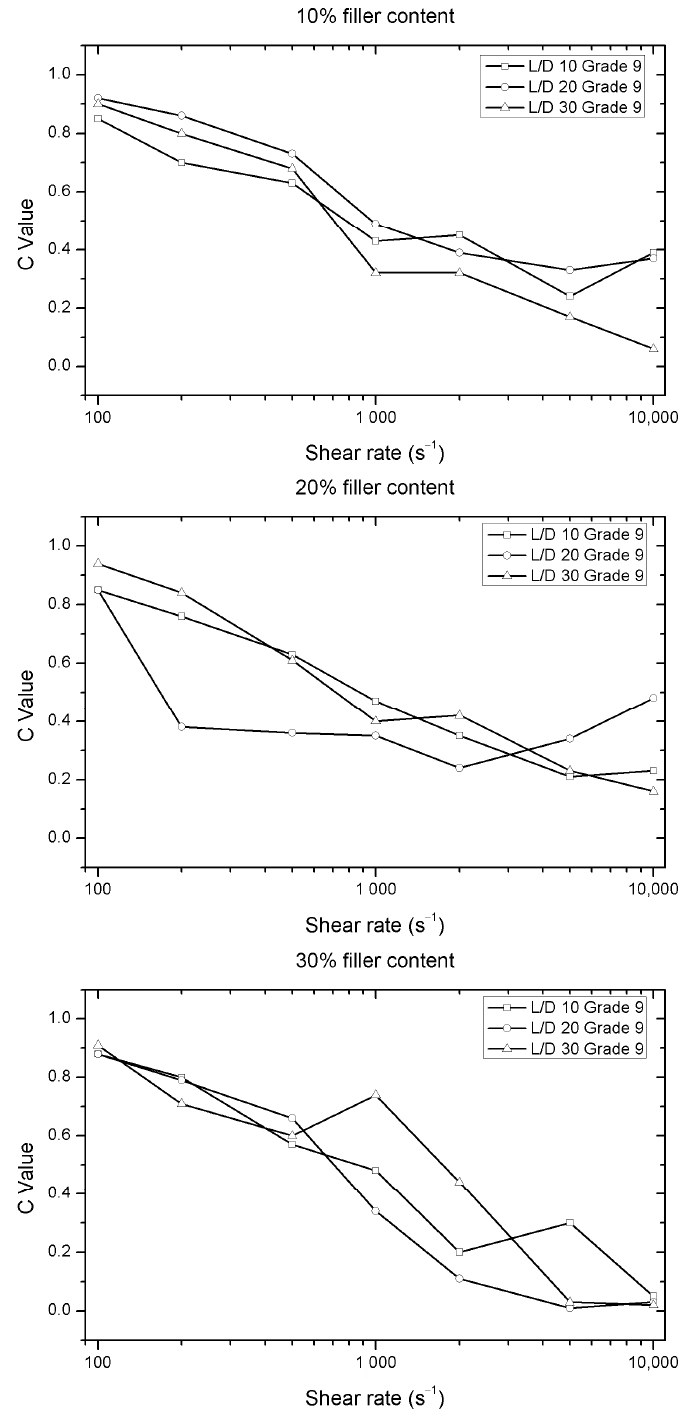
Figure 8. Evolution of C values versus shear rate for di ff erent nozzles length of the Solanyl ® with di ff erent percentages of fillers (Grade 9).